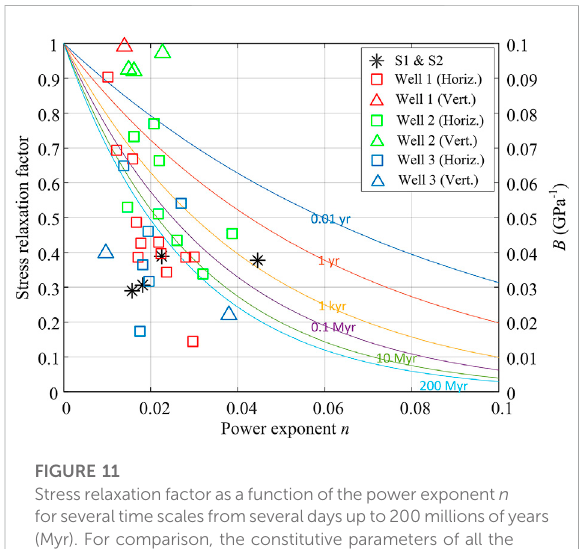
FIGURE 12 Stress accumulation (contours) as a function of the constitutive parameters ( B and n ). In the calculation, a constant strain rate of 10 – 19 and a deformation duration of 150 Myr are assumed. The constitutive parameters of all studied samples are also